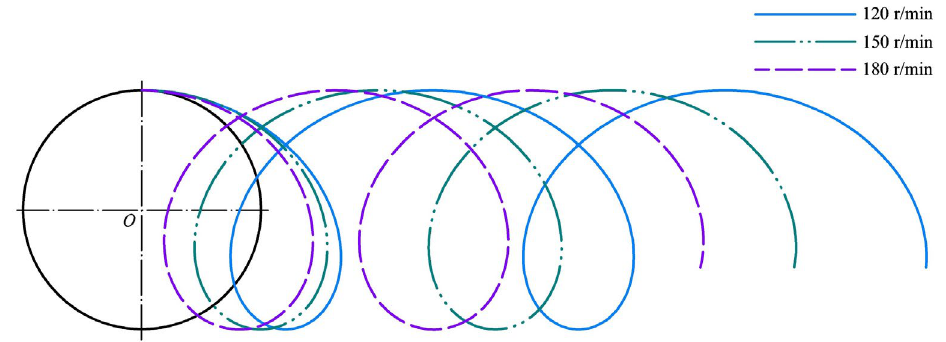
Figure 9. Motion trajectory of spring teeth at different speeds.